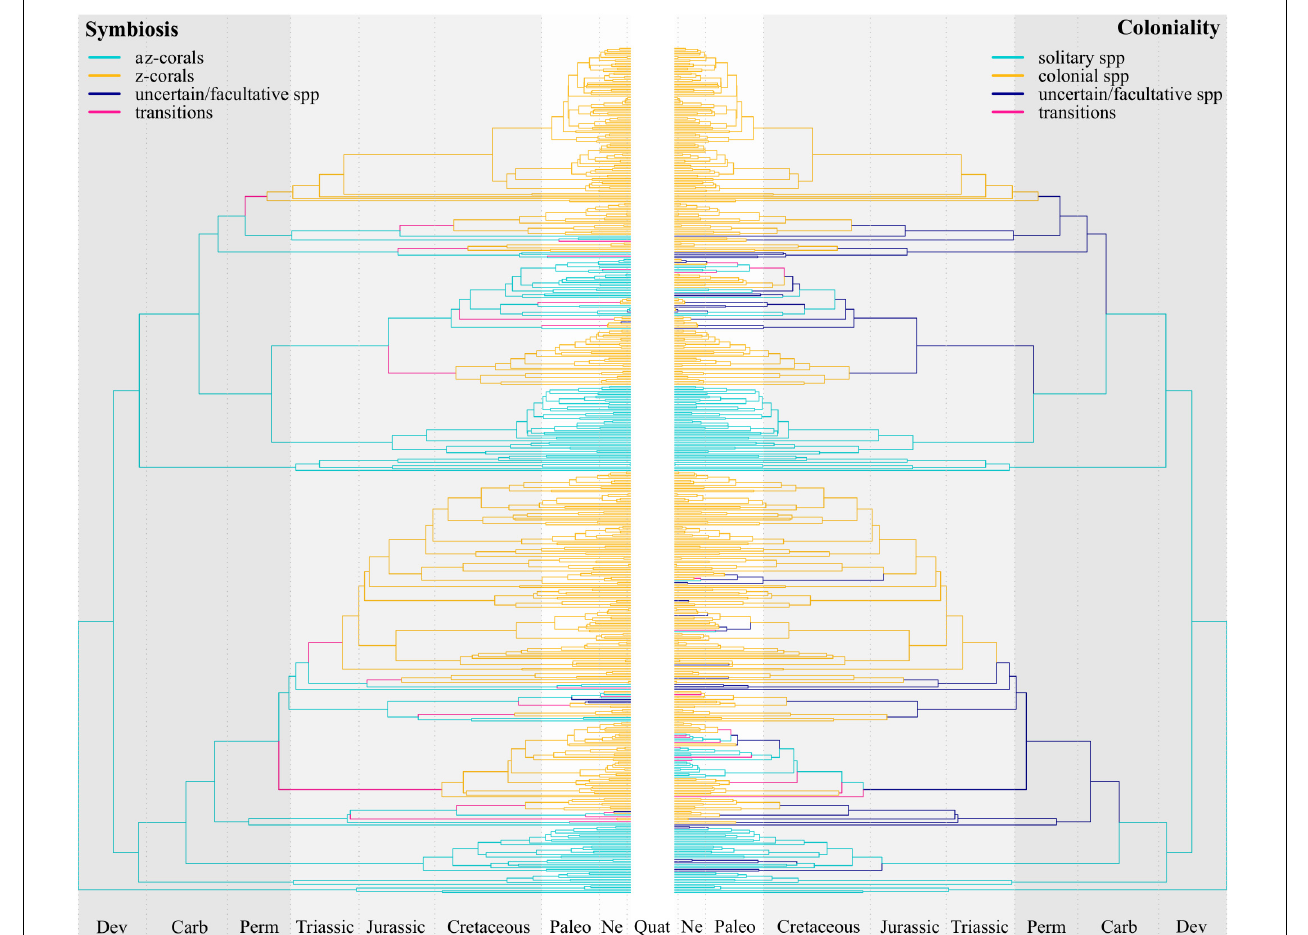
FIGURE 3 | Ancestral state reconstruction for symbiosis (left) and coloniality (right) from a Covarion model of correlated evolution. Branches states are represented according to the ancestral and descendent values assigned to the nodes. Nodes states are assigned when median P p > 0.75 or double for one state than the other. When two nodes defining a branch had the same state, it was assigned to the branch. If the state differed, the branch was classified as transition from the ancestral state to the descendant. If one or the two nodes was uncertain (because it did not meet the criteria), the branch was also considered uncertain. This category can also correspond with a facultative species, in which the two states are present, and the Pp are similar. Time frames correspond to geological periods: Devonian (Dev), Carboniferous (Carb), Permian (Perm), Triassic, Jurassic, Cretaceous, Paleogene (Paleo), Neogene (Ne), and Quaternary (Quat). The three colors represent the Paleozoic, Mesozoic, and Cenozoic geological